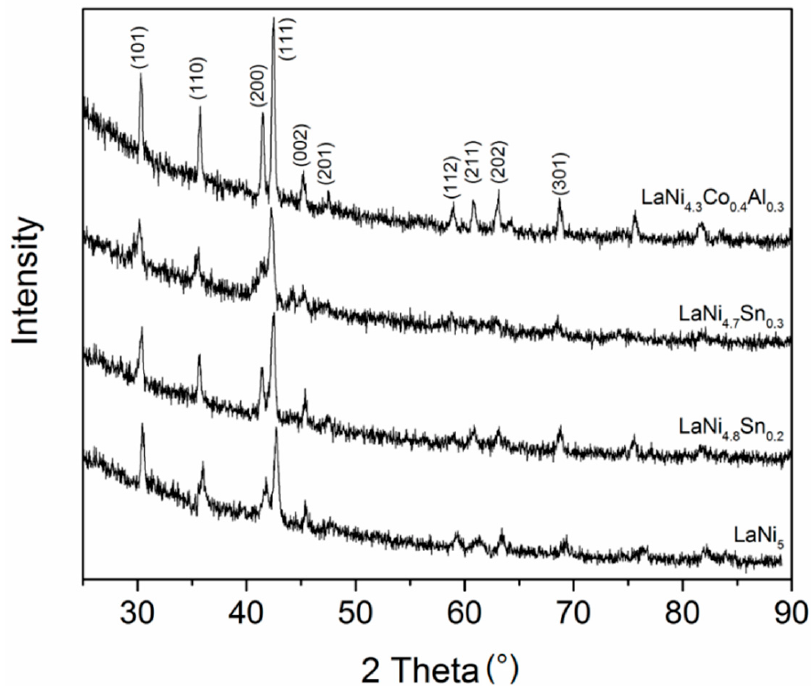
Figure 1. X-ray diffraction (XRD) patterns of the studied LaNi 5 based alloys (Cu-K α radiation). Table 1. Experimentally determined lattice parameters, the crystal cell volume and the Atomic Radius Factor for LaNi 5 based alloys.